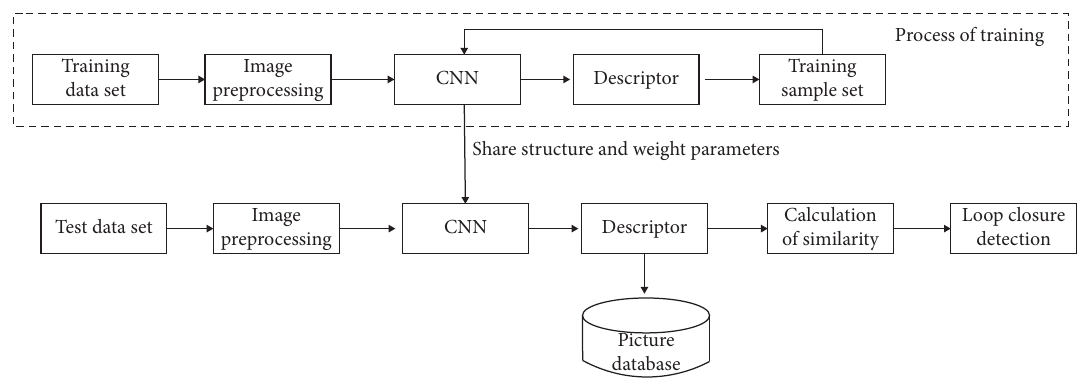
Figure 17: Based on deep